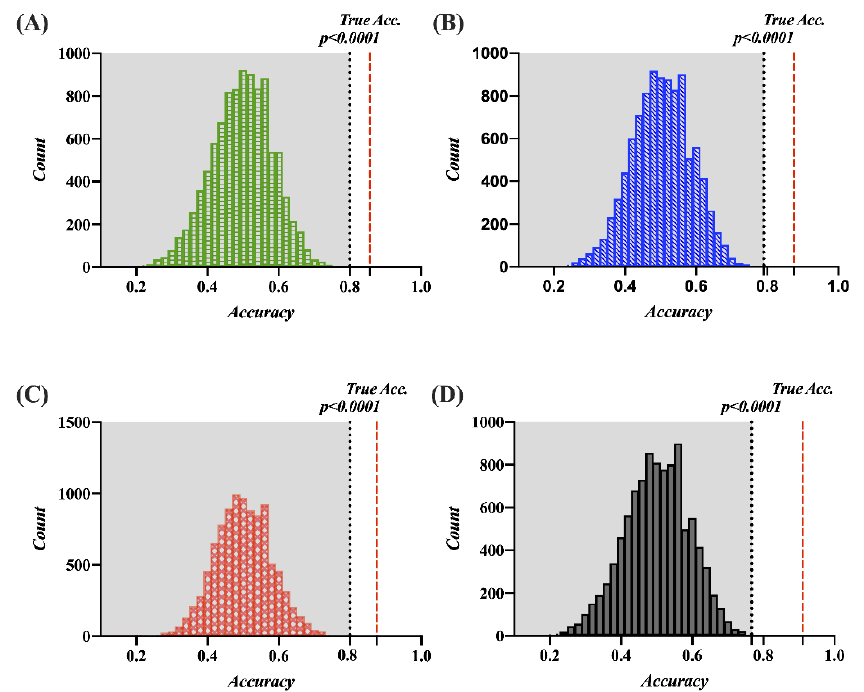
Figure 8. Results of the distributions for the four classifiers for the permutation test ( p < 0.0001). ( A ) ( A ) LDA. ( B ) KNN. ( C ) DT. ( D ) LDA. ( B ) KNN. ( C ) DT. ( D ) LSVM.